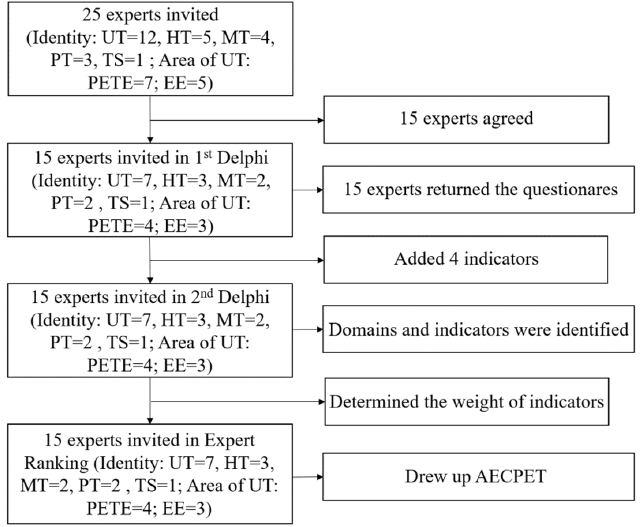
Figure 1. Procedure of the Delphi and expert ranking process.